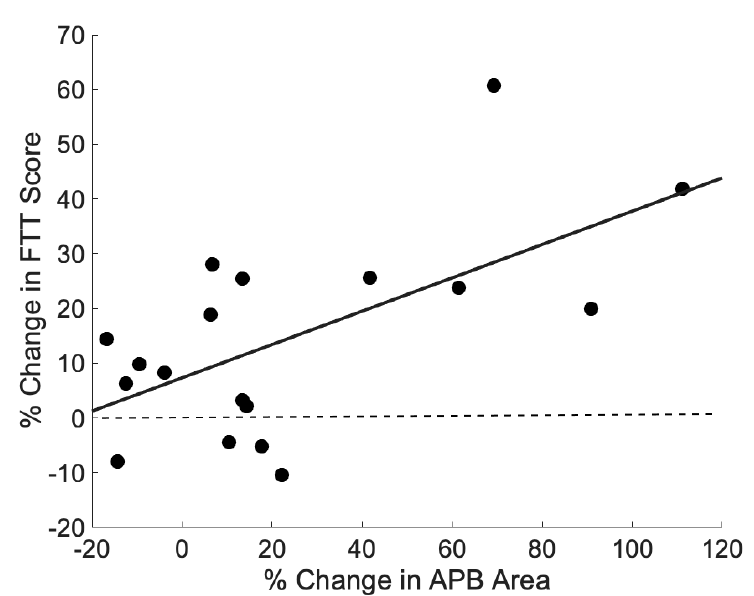
Figure 5. Plot of the percent change in cortical map area versus the percent change in FTT score for all 18 subjects ( r = 0.61, p = 0.007). A simple linear regression line was fit to the data.